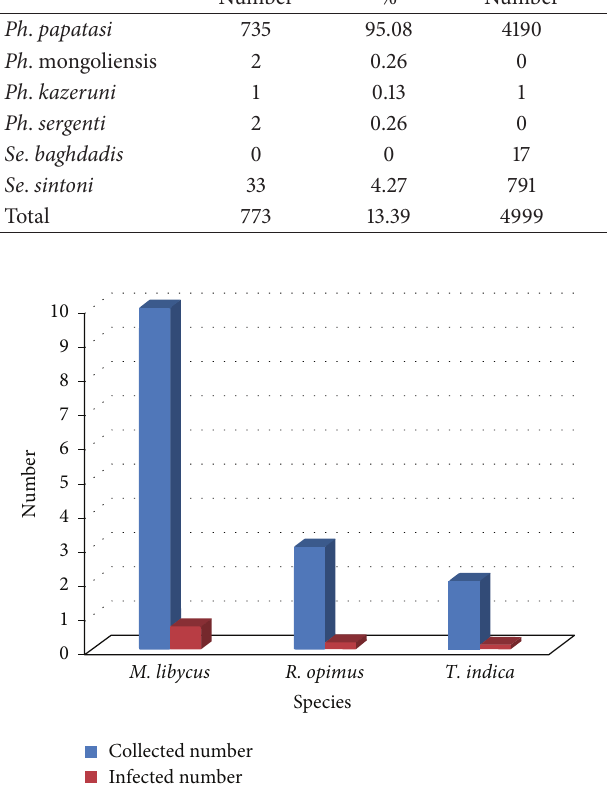
Indoors Outdoors — —